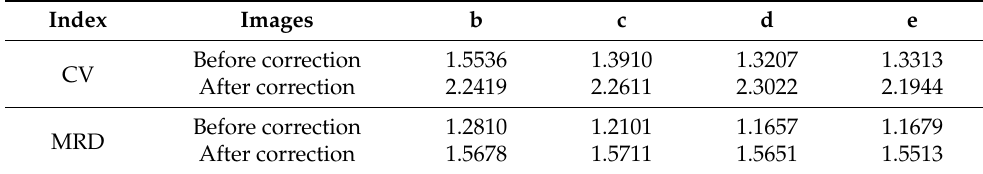
Table 2. Quantitative assessment of the real data